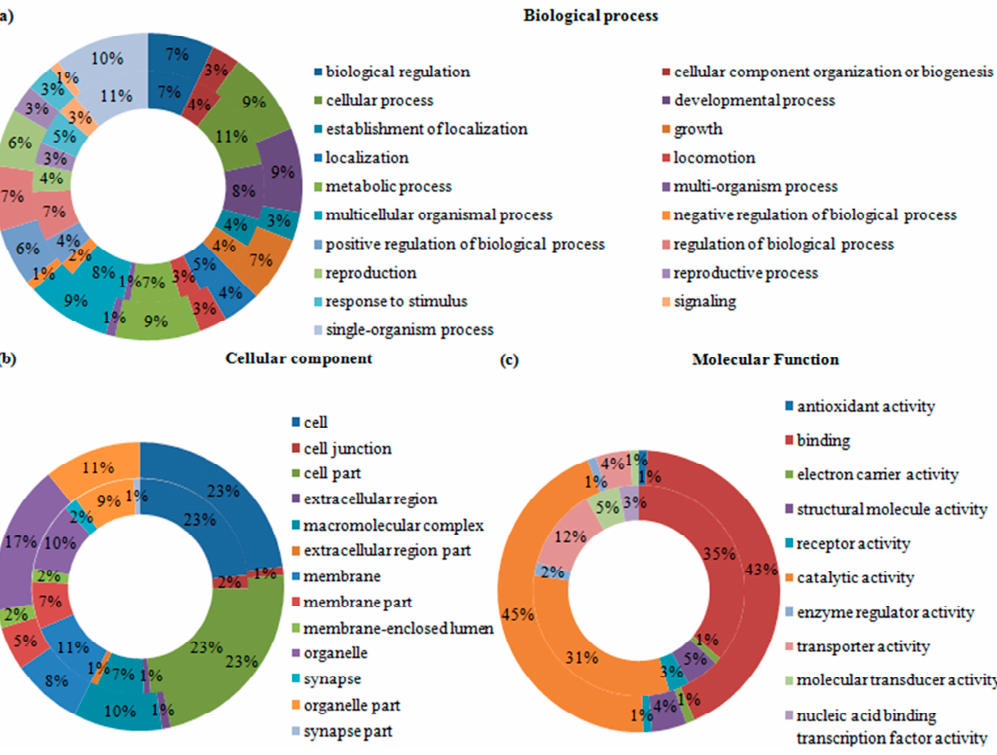
Figure 3. Gene ontology (GO) terms were assigned to the significantly down-regulated transcripts and proteins in highly and weakly virulent Bursaphelenchus mucronatus ( B. mucronatus ) isolates. The percentage of each category shown is based on the three groups: ( a ) biological process; ( b ) cellular component; and ( c ) molecular function. External ring = protein; internal ring = transcript.